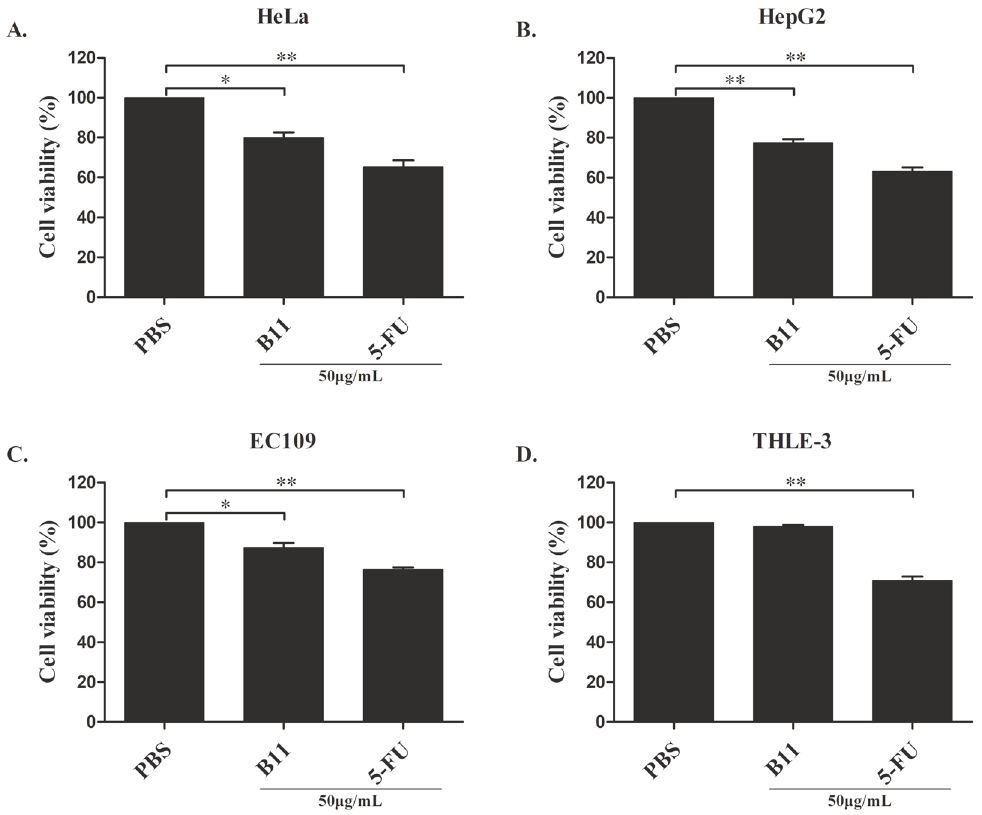
Figure 2. Inhibitory effects of peptide B11 on growth of immortalized cancer and non-cancer cells. The cancer cell lines ( A ) human cervical cancer (HeLa) cells, ( B ) human hepatocellular carcinoma (HepG2) cells, ( C ) human esophageal cancer (EC109) cells, and immortalized normal human liver cells ( D ) THLE-3 cells (T-antigen-immortalized human liver epithelial (THLE) cells) were grown for 24 h in the presence of 50 μ g/mL of peptide B11. Cell proliferation was analyzed using the MTS assay with PBS used as the negative control, while 5-fluorouracil (5-FU) was used as the positive control. Data represent means ± SD for three independent experiments ( n = 3). Significant difference relative to control (PBS-treated cells) were determined by one-way ANOVA and indicated by asterisks (* p < 0.05, ** p < 0.01 ).